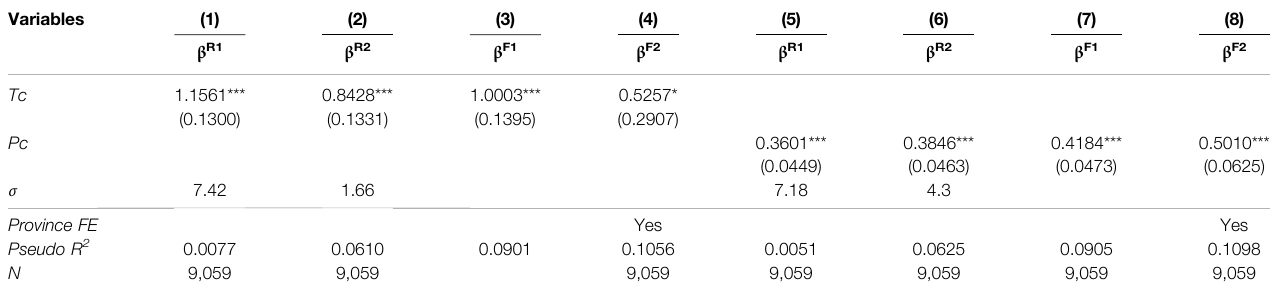
TABLE 4 | Robustness test results: Oster ’ s method. Variables